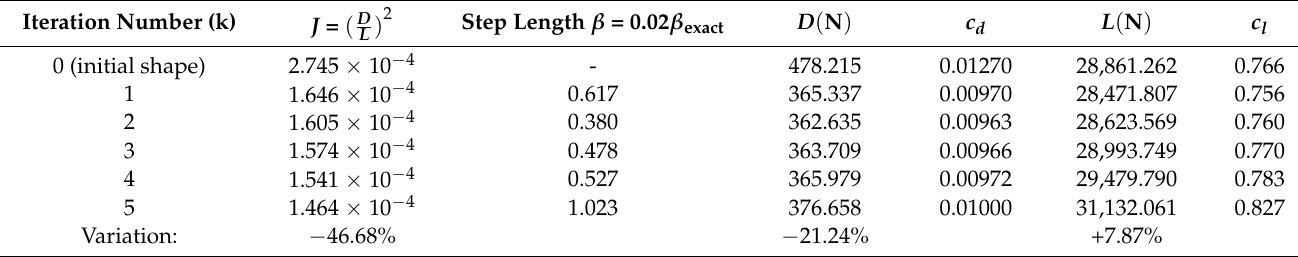
Table 4. Results for Test case I.